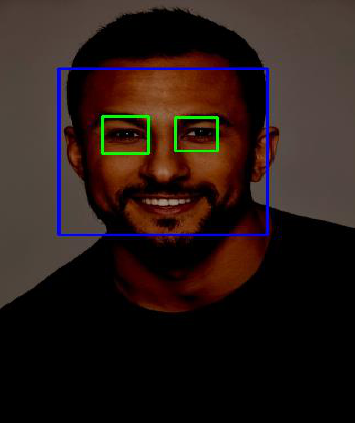
Figure 23. Slightly reduce the brightness in Figure 21.